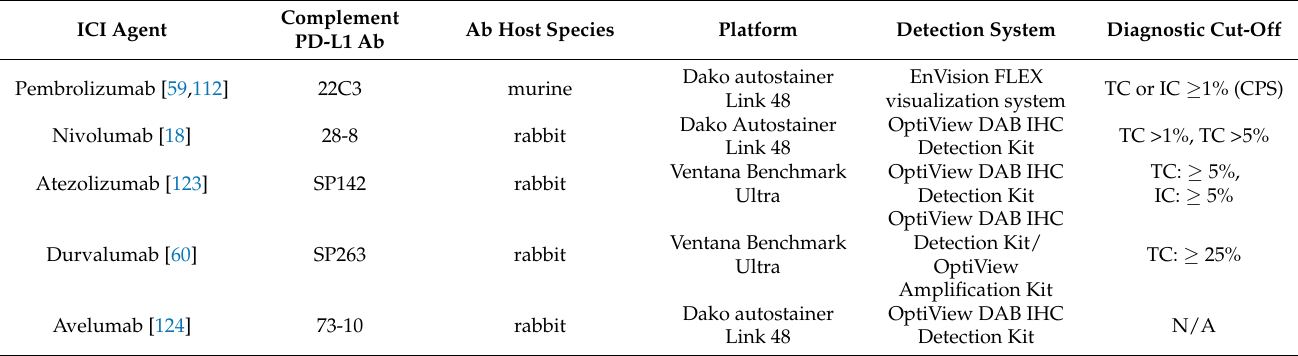
Table 1. Different antibodies and platforms for ICI tested in